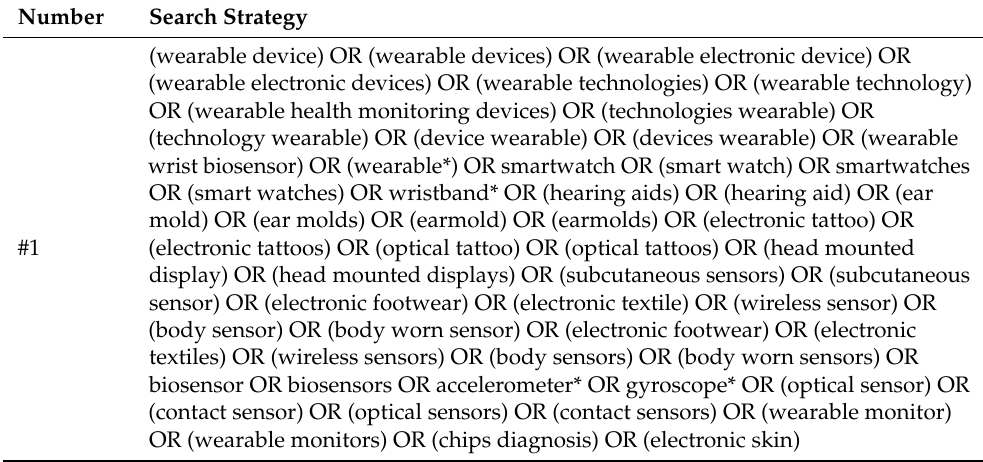
Table 1. Keywords and search strategy for the Medline database